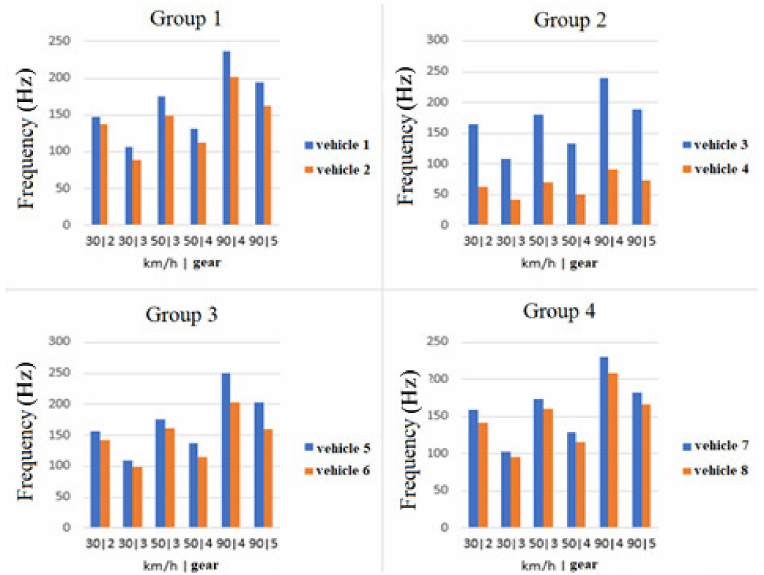
Figure 4. Comparison of the dominant harmonic vibrations’ values measured on the engine (Figure 1) in particular groups; for the older (blue) and the newer models (orange).